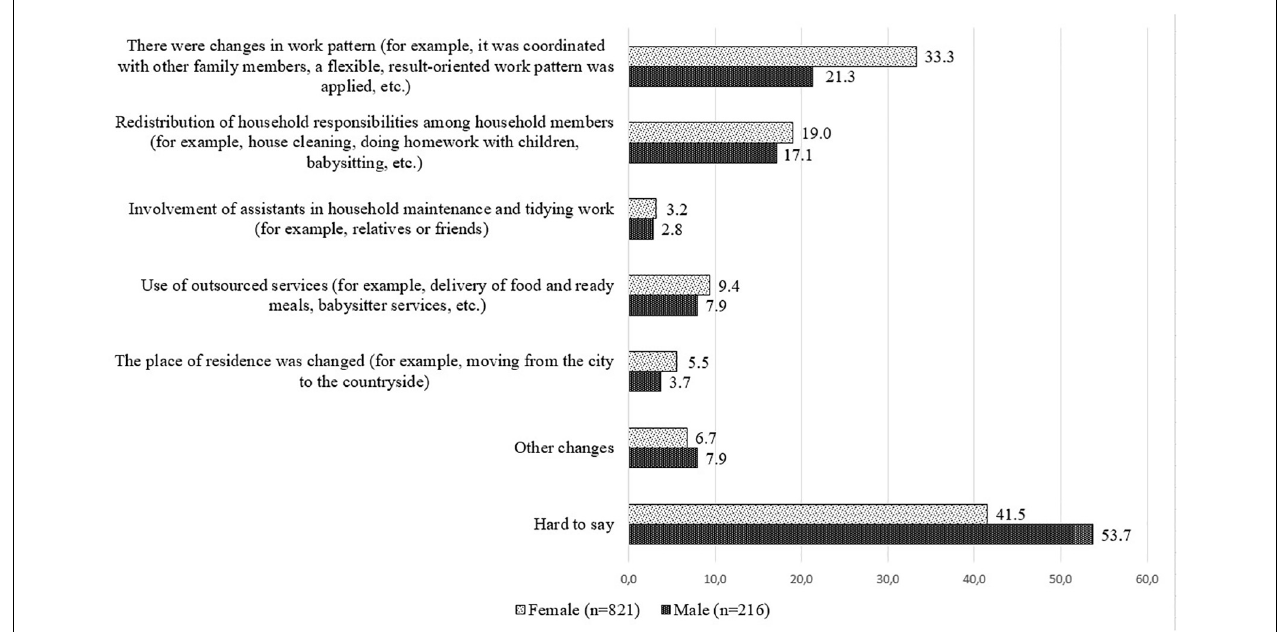
FIGURE 1 | Distribution of answers of the employed respondents to the question “Please mark what changes were made to your household’s daily routine during COVID-19 to enhance work–life balance?”; gender; %.